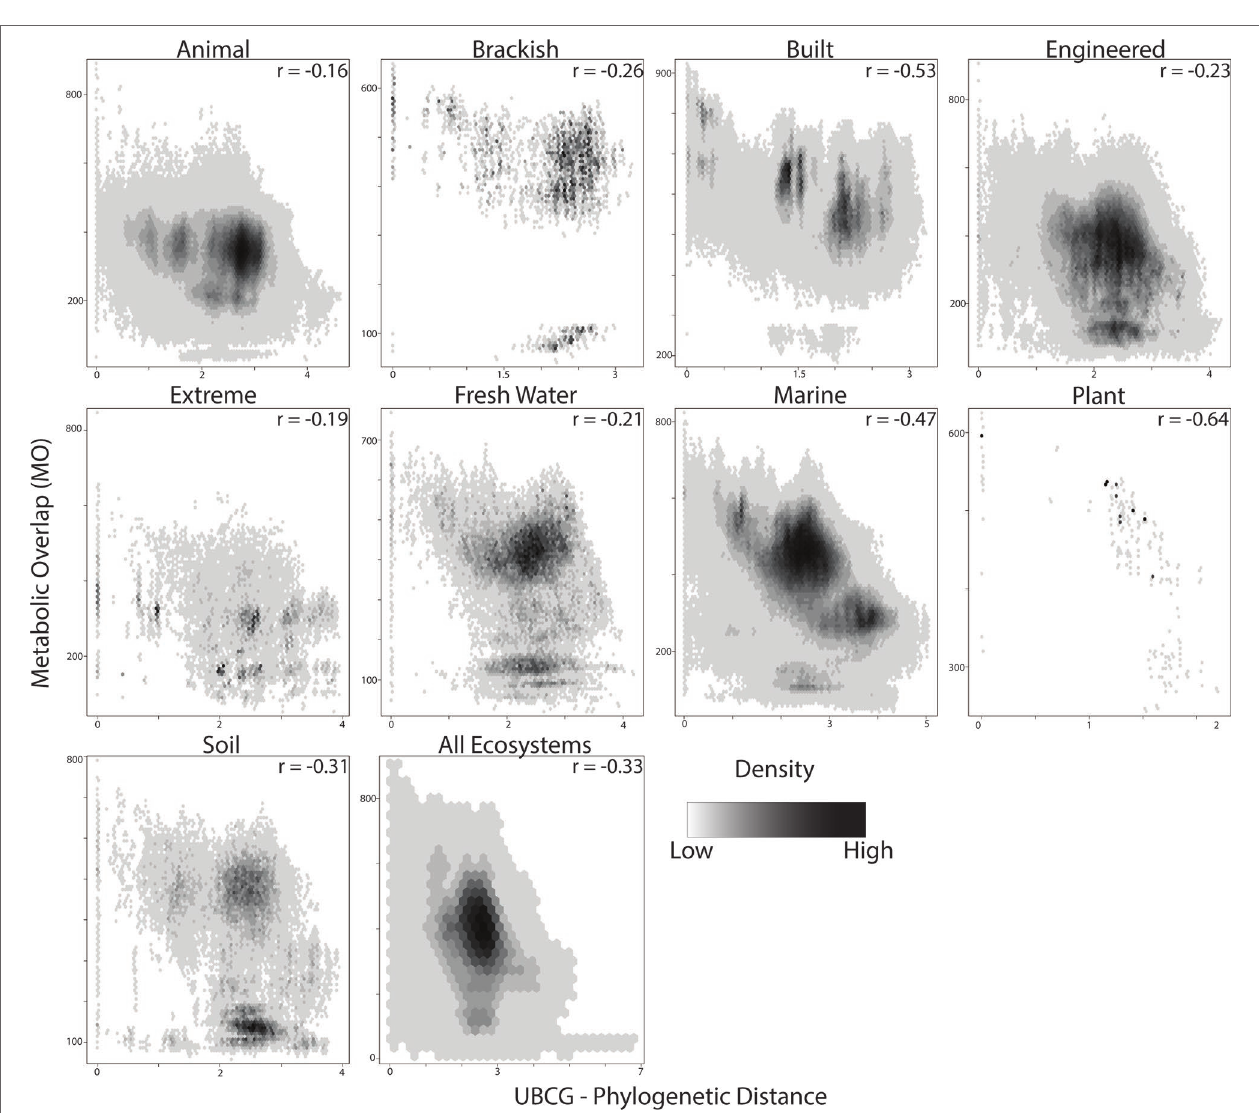
FIGURE 5 | Relationship between metabolic overlap and phylogenetic distance. Each point represents a pairwise comparison between two MAGs. The density of points is represented by a black and white gradient. The Spearman correlation coefficient is indicated in the upper left-hand corner of each